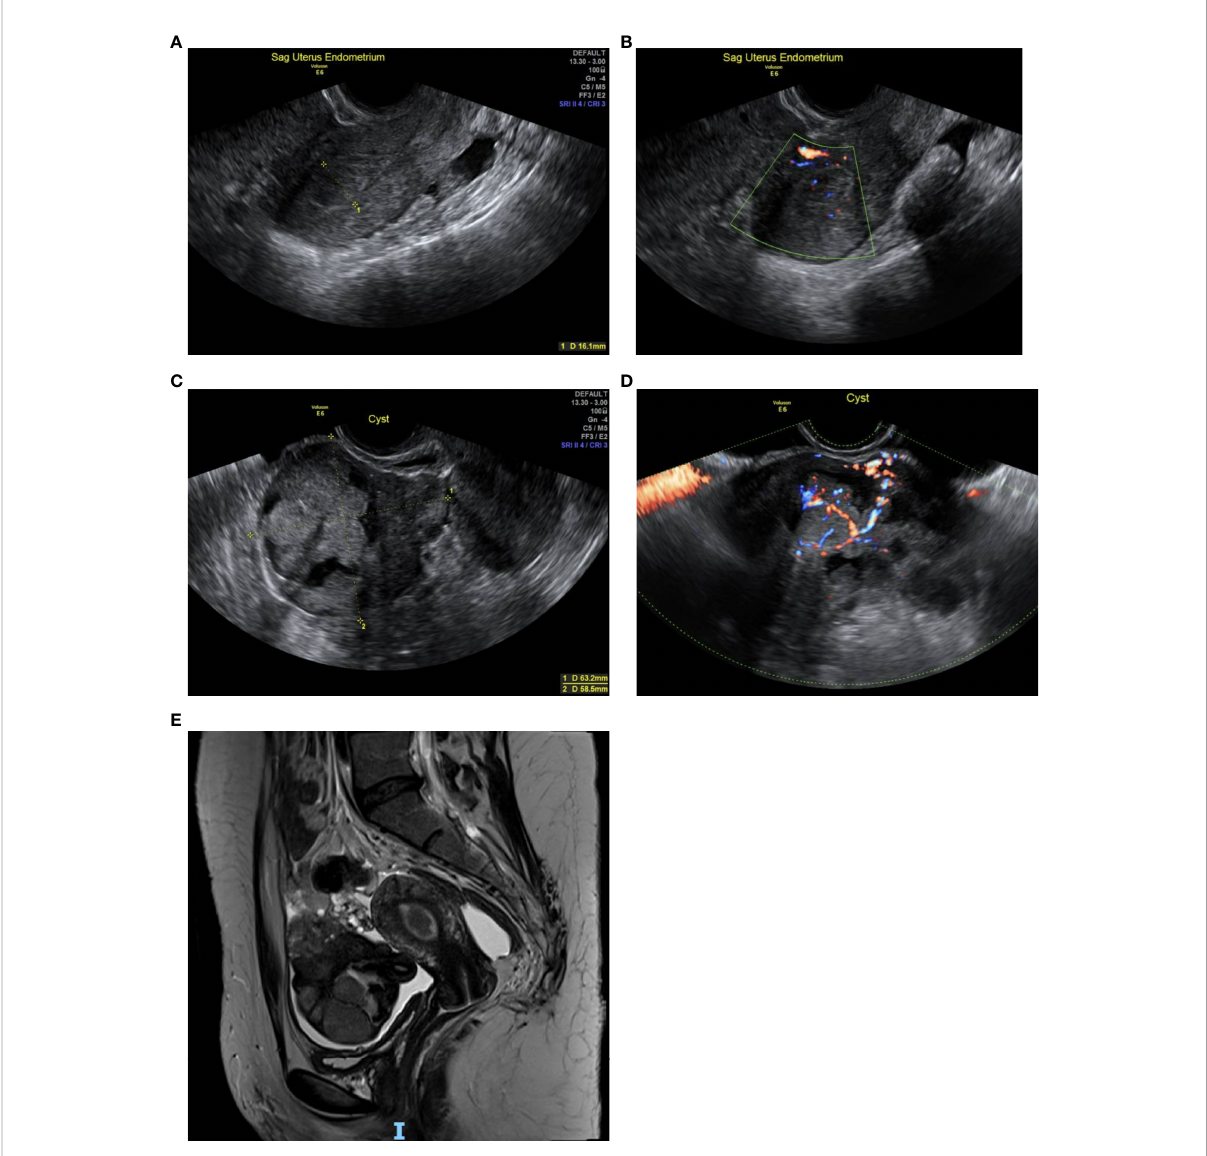
FIGURE 1 (A) : Transvaginal scan (TVS) of the uterus shows an endometrial thickness of 16 mm. (B) : TVS of the uterus shows anechoic areas with Doppler colour fl ow within the endometrial cavity. (C) : TVS shows a right adnexal solid cystic mass measuring 74 x 58 x 63 mm, with the solid component measuring 40 mm. (D) : TVS with colour Doppler, demonstrating moderate blood fl ow through the right adnexal mass. (E) : Pelvic MRI shows a polypoidal lesion in the uterine cavity. The right adnexal mass is seen within a pool of free ascitic fl uid extending both behind and in front of the